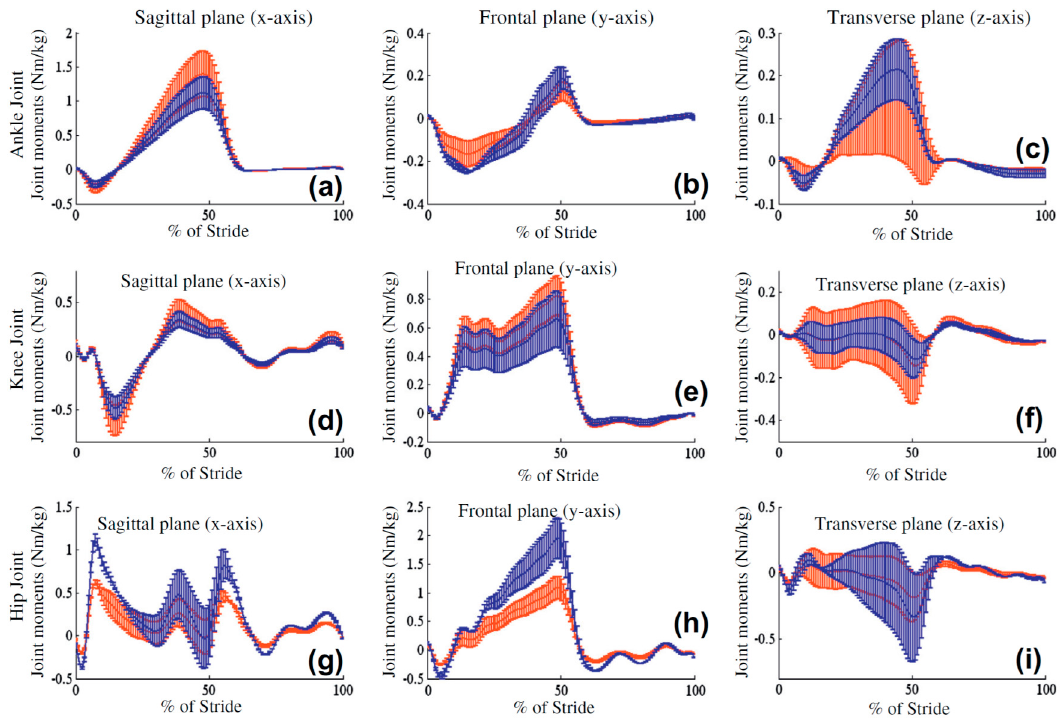
Figure 19. Comparison on tri-axial joint moments measured by the wearable system (red) with the reference measurements (blue) for ankle ( a – c ), knee ( d – f ) and hip joint ( g – i ). A standard deviation above and below the mean values are presented for the four subjects (after [100]).